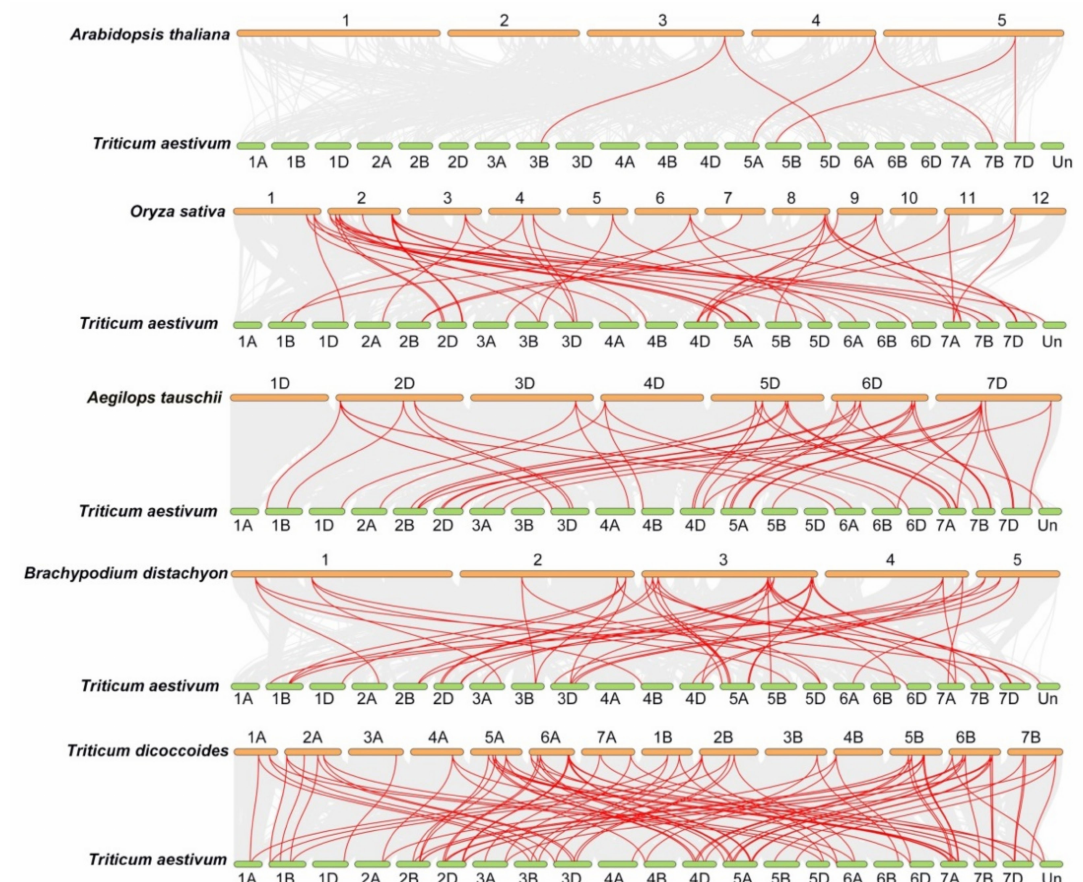
Figure 3. Syntenic relationships of TaFKBP genes between Aegilops tauschii , Brachypodium distachyon , Triticum dicoccoides , Oryza sativa and Arabidopsis thaliana . The gray lines in the background represent the collinear blocks with Triticum aestivum genomes, while red lines highlight the syntenic FKBP gene pairs. The labels within the figure indicates chrosomal